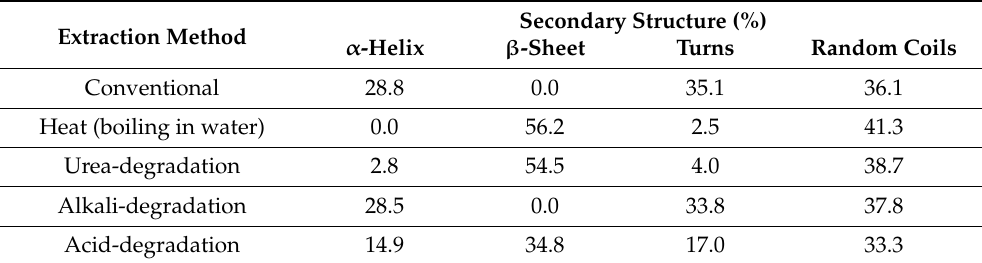
Table 2. Percentage (%) of secondary structures ( α -helix, β -sheet, turns and random coil) of silk sericin from B. mori extracted through different methods. Adapted from [16]. Secondary Structure (%) Extraction Method α -Helix β -Sheet Turns Random Coils